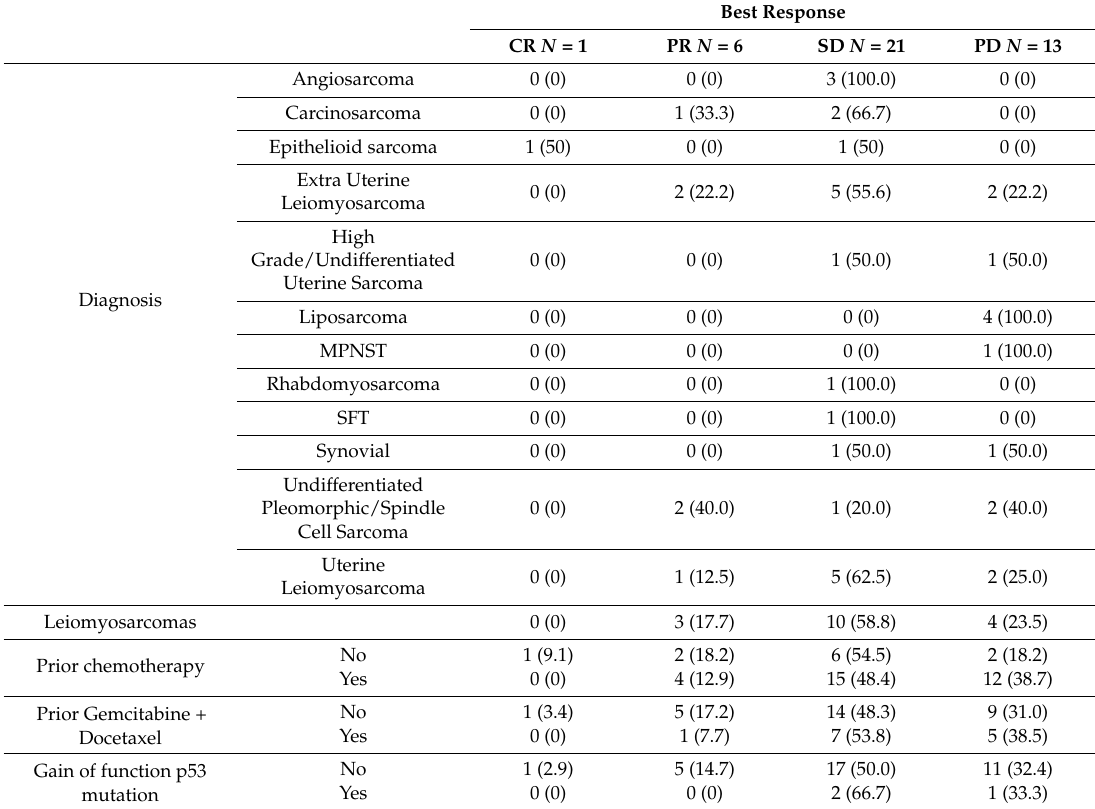
Figure 2. Summary of efficacy represented by swimmer’s plot. One complete response in epithelioid sarcoma and 6 partial responses in carcinosarcoma (1), extrauterine (1) and uterine leiomyosarcoma (2), and undifferentiated pleomorphic sarcoma (2).